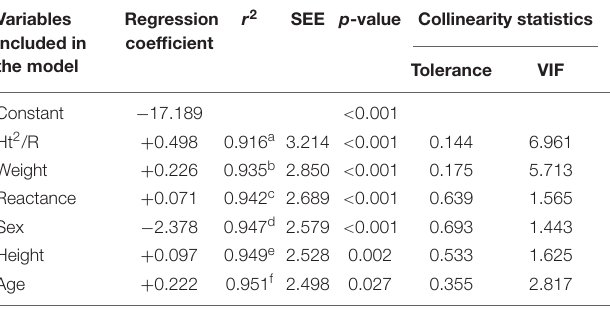
TABLE 4 | Regression model for the prediction of fat-free mass (kg).